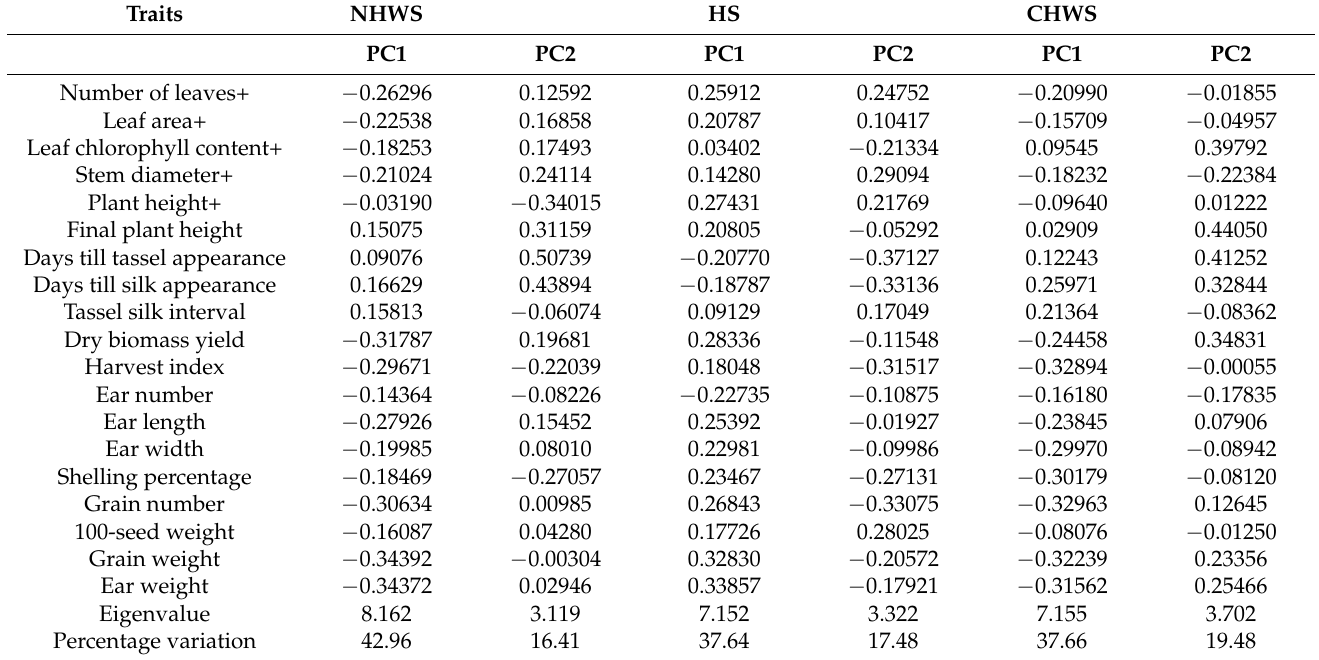
Table 2. Principal component analysis of 19 maize traits under varied stress